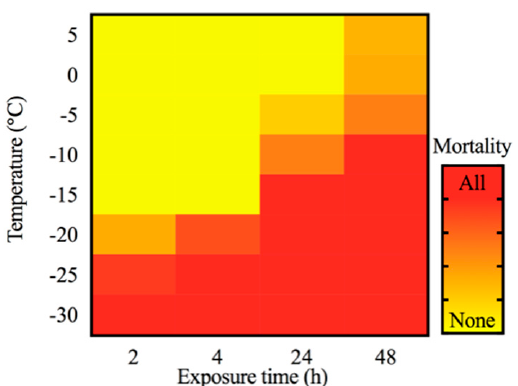
Figure 3. Mortality of overwintering larvae from the YS population under different exposure times during mid-winter. Red indicates a high mortality rate and yellow indicates there was low mortality or there was no mortality. The gradual transition from yellow to red corresponds to an increase in the mortality of samples from none (mortality 0%) to all (mortality 100%).